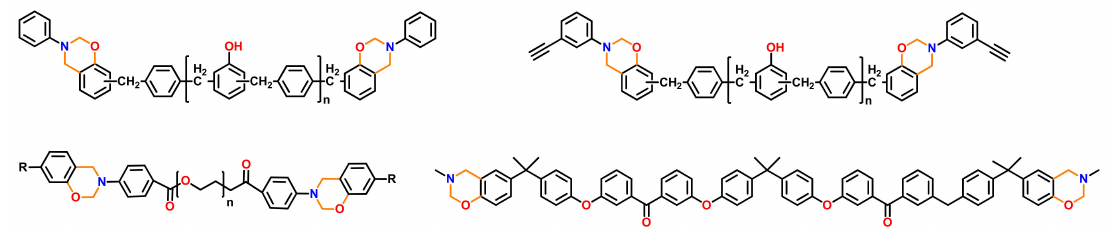
Figure 25. Representative structures of telechelic benzoxazines